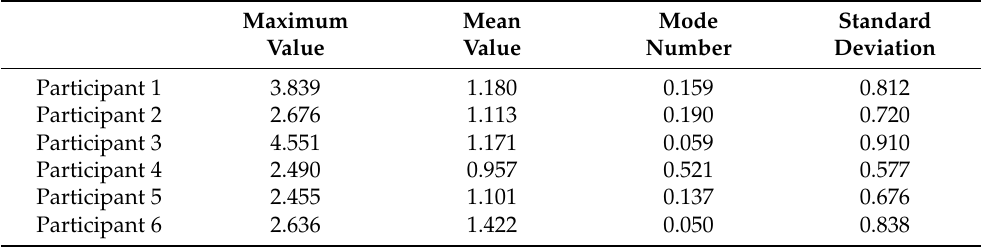
Table 3. Force tracking error analysis of sinusoidal response experiments on six